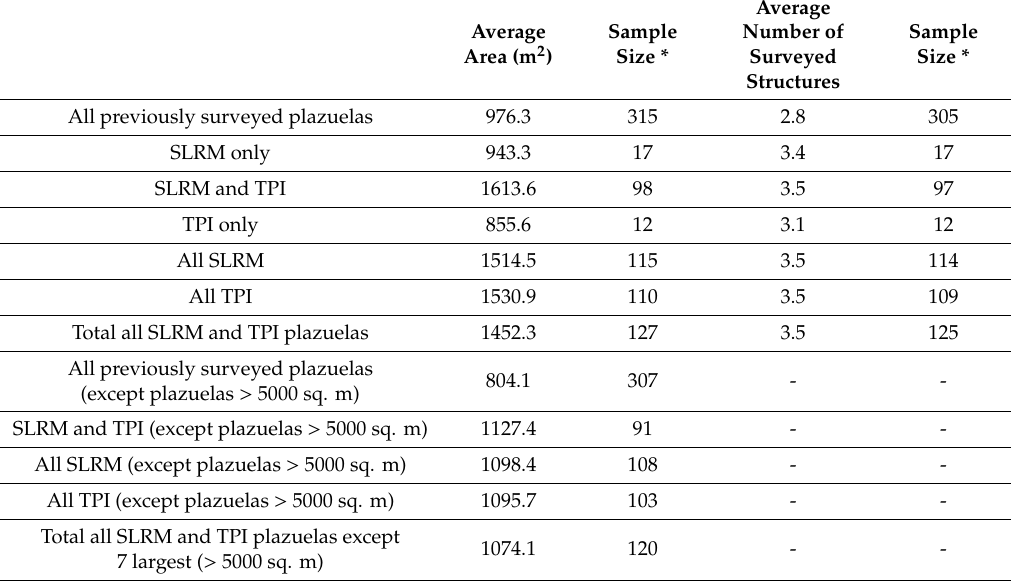
Table3. Sizeofplazuelasandnumberofstructures(basedonpedestriansurveydata)thatwereidentified with SLRM and TPI. Larger plazuelas are more likely to be remotely identified. * Some plazuelas do not have areas calculated or number of structures